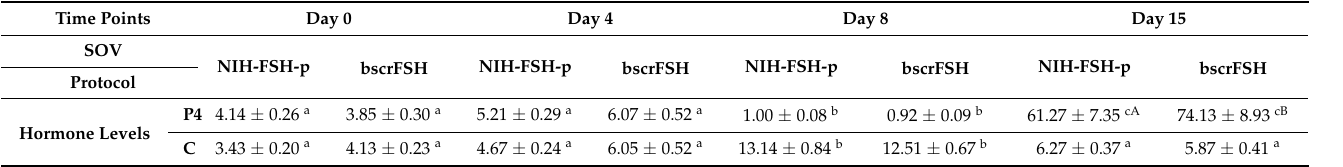
Table 3. Hormone level profiles (progesterone (P4) and cortisol (C)) over time: NIH-FSH-p vs. bscrFSH SOV